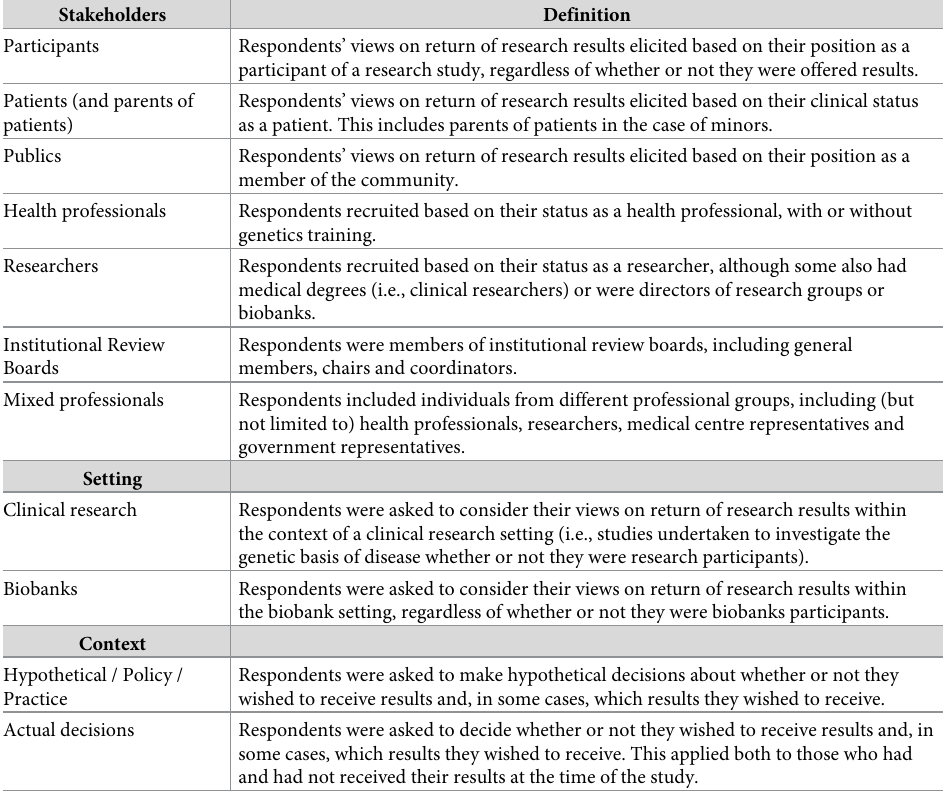
Table 1. Glossary of stakeholder, setting and context